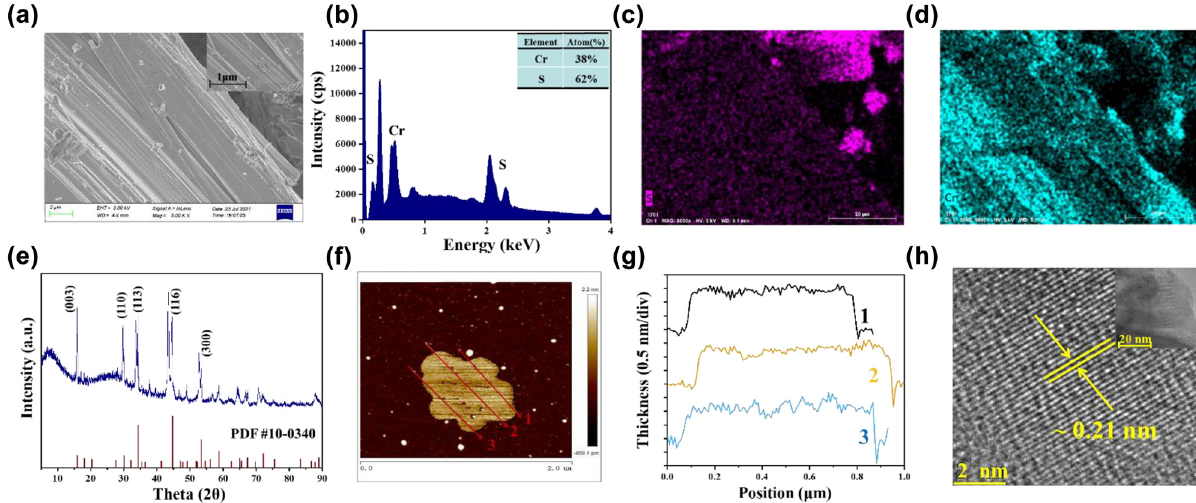
S material. (a) SEM image of Cr 2 3